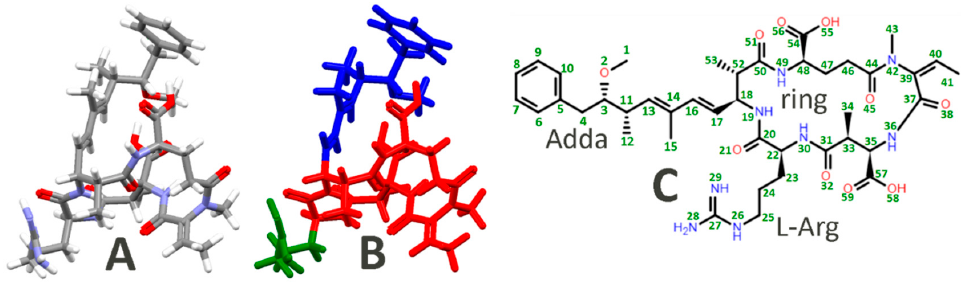
Figure 7. Optimized structure of NOD in gas phase at APFD/6-311+G(2d,p) level of theory ( A ) with the three main chemical components marked ( B ) in red—the main ring, blue—Adda, and green—L-Arg. The atom labels used in DFT calculations are shown on Nodularin’s chemical structure ( C ).